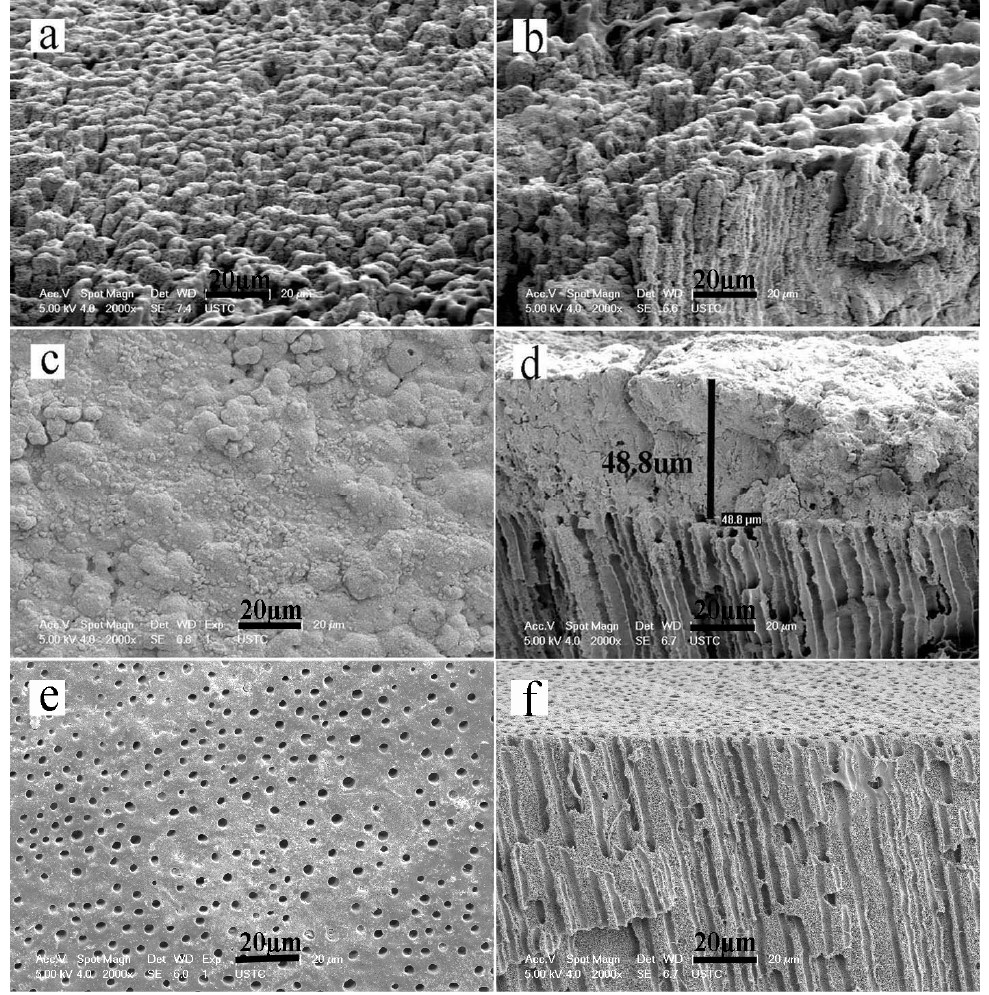
Figure 3. SEM micrographs of remineralized dentin slices. Panels a, c and e are surface images. Panels b, d, and f are cross ‐ sectional views of the samples shown in panels a, c, and e, respectively. ( a , b ) The minerals deposited on the dentin surface after two cycles; ( c , d ) The minerals deposited on the dentin surface after six cycles of remineralization; ( e , f ) The minerals deposited in the control group that did not include the aid of an electric field after six cycles of remineralization.